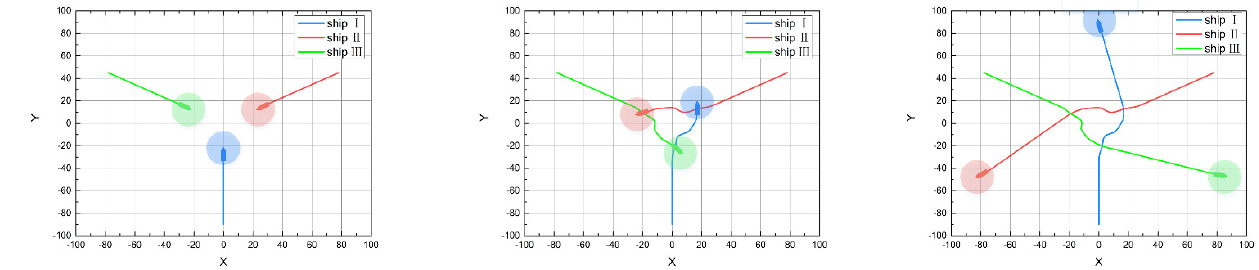
Figure 14. Three ships encountering scenario. (Unit: 10 m).